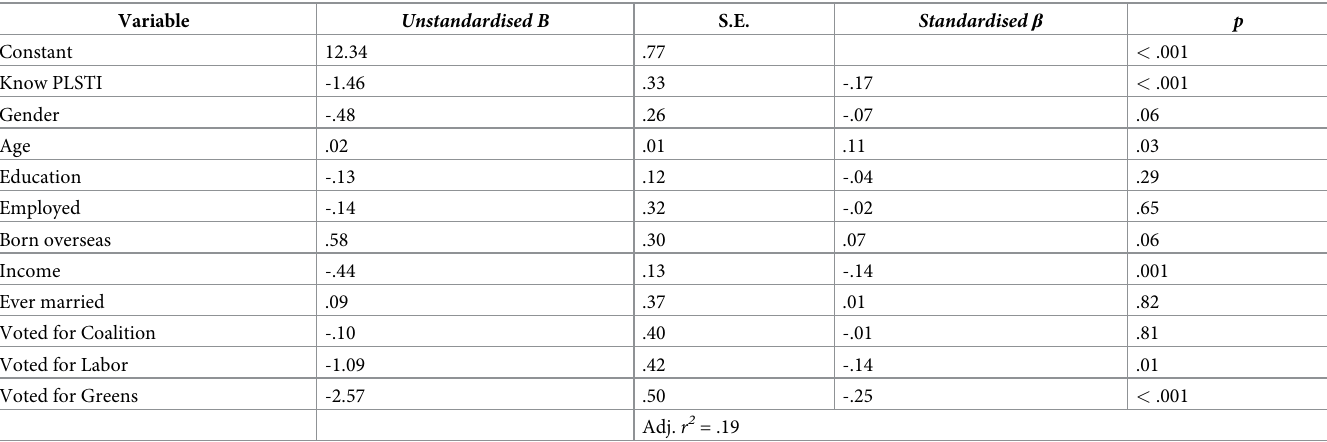
Table 5. Multiple regression results with people living with sexually transmissible infections stigma scale scores as the dependent variable.